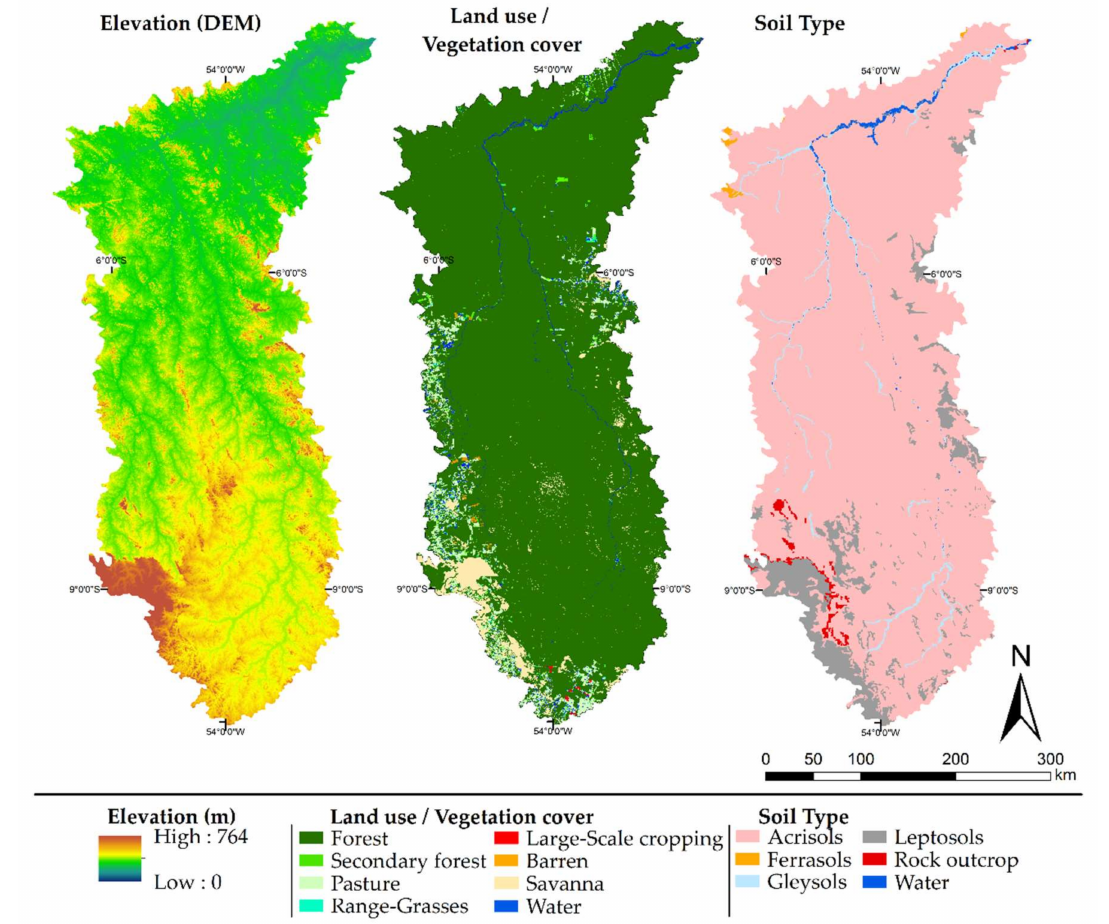
Figure 2. The Digital Elevation Model, land cover, and soil types in the Iriri River